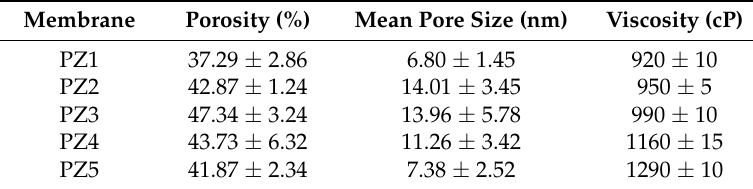
Table 2. The porosity, mean pore radius, and viscosity of PZ1 to PZ5. Membrane Porosity (%)